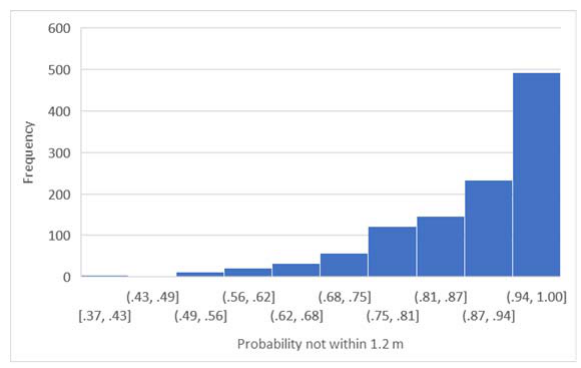
Figure 5. The case when the true distance is 2.0